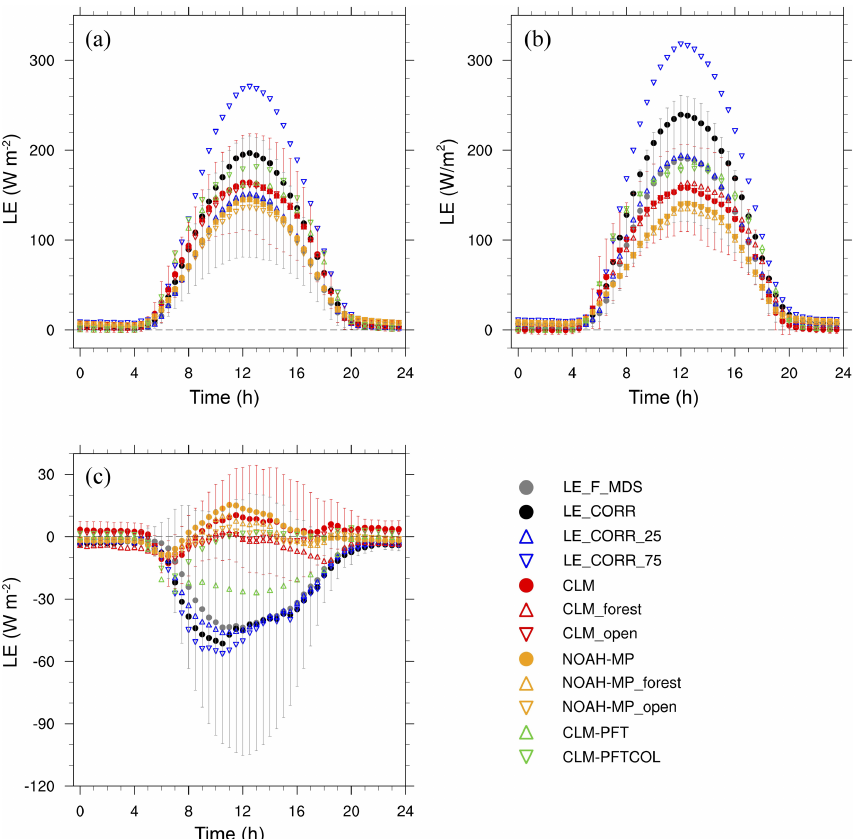
Figure 2. The diurnal cycle of LE (Wm − 2 ) averaged over all the open sites (a) and forest sites (b) and their difference (open − forest, c ) during the summer. The gray error bars indicate the standard deviation of the observed LE (MDS) among the sites; the red error bars are for the simulated LE in the CLM case. Details about the four types of FLUXNET observations can be found in Table 1. Information about model simulations in the CLM and Noah is given in Table 2.